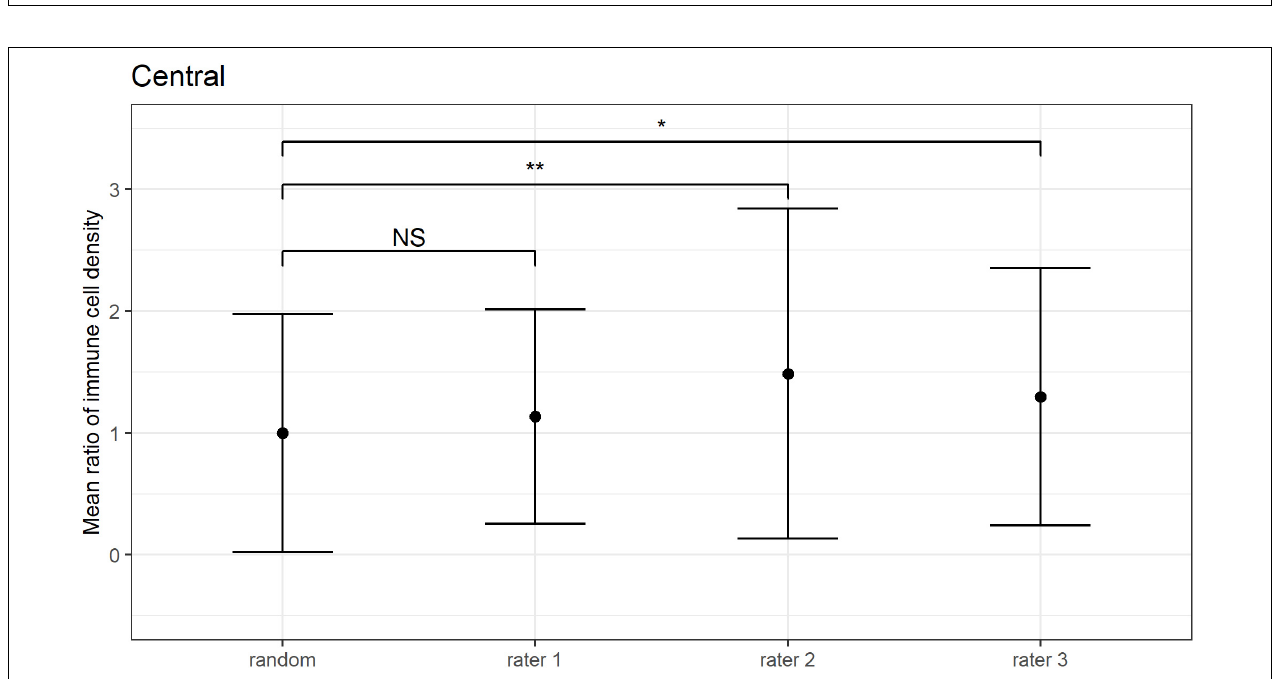
FIGURE 6 | Central corneal epithelial immune cell (IC) density mean ratios, and corresponding 95% CIs, obtained when IC density estimates derived from all combinations of three randomly sampled images (random), and when the “three representative images” were independently selected by three observers (i.e., raters 1 to 3). Mean ratios of IC density estimates derived from images selected by rater 2 and rater 3 were significantly higher in comparison to 3 randomly sampled images (** p = 0.01; * p < 0.05; NS: p > 0.05).